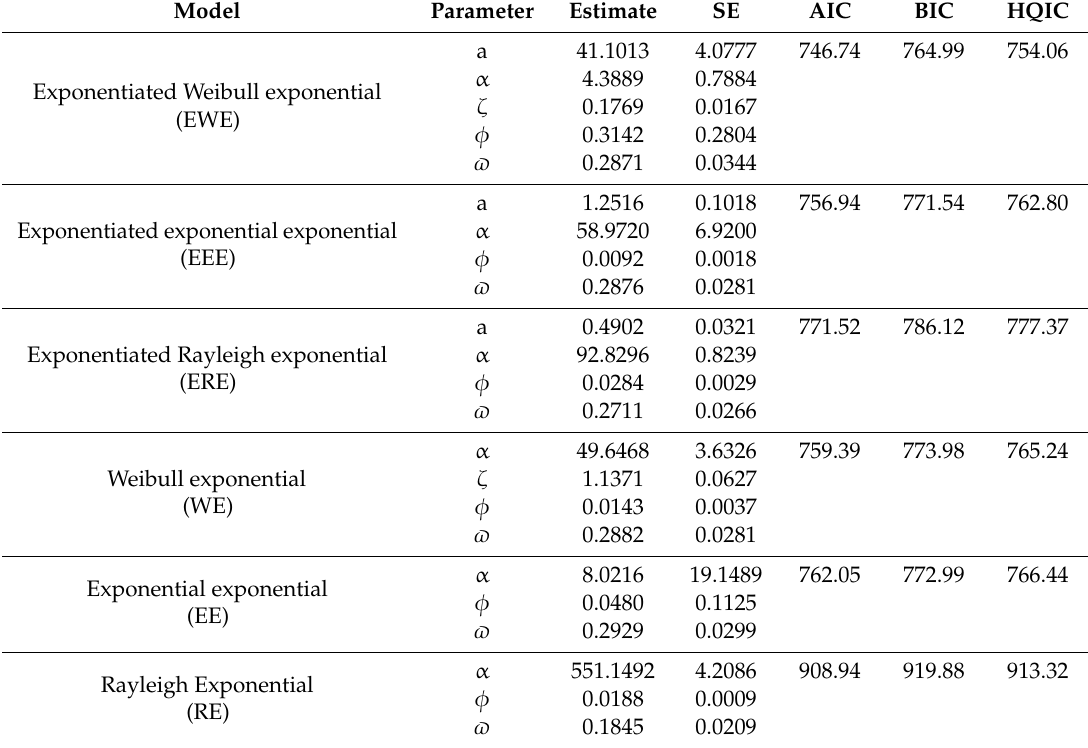
Table 3. Results of maximum likelihood estimates, considering the geometric non-mixture cure model (GNMCM) for e1684 data without